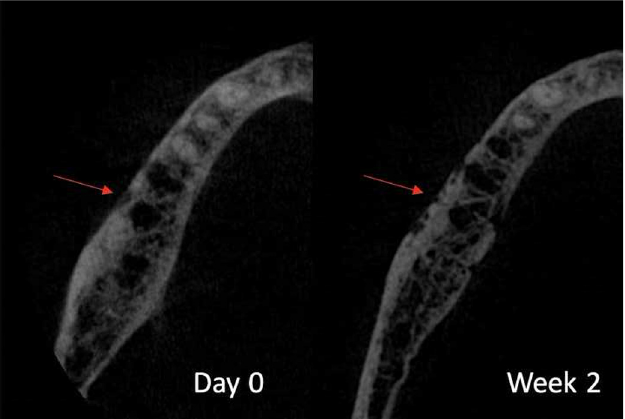
Fig. 2. CBCT imaging at the day of the extraction and at the follow-up appointment at 2